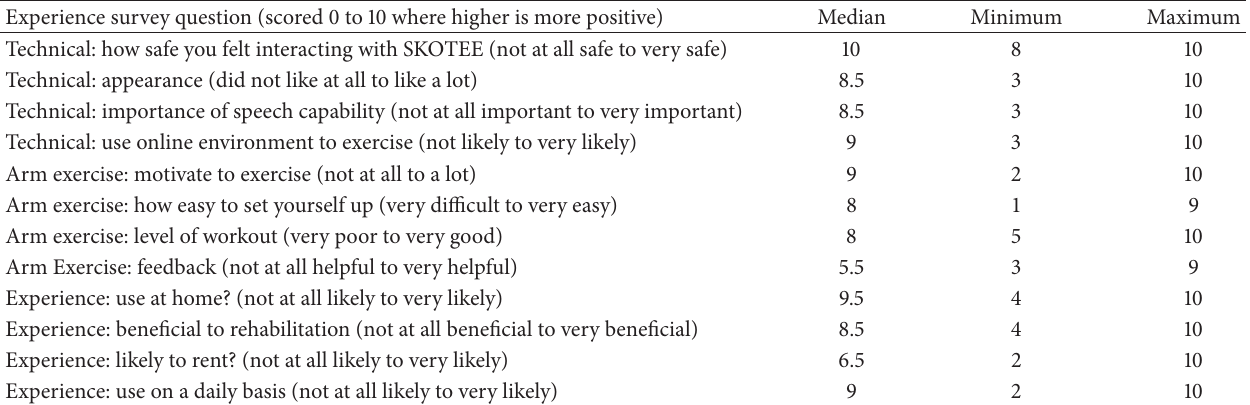
Table 1: Results of the experience survey ( 𝑁 = 10 ).